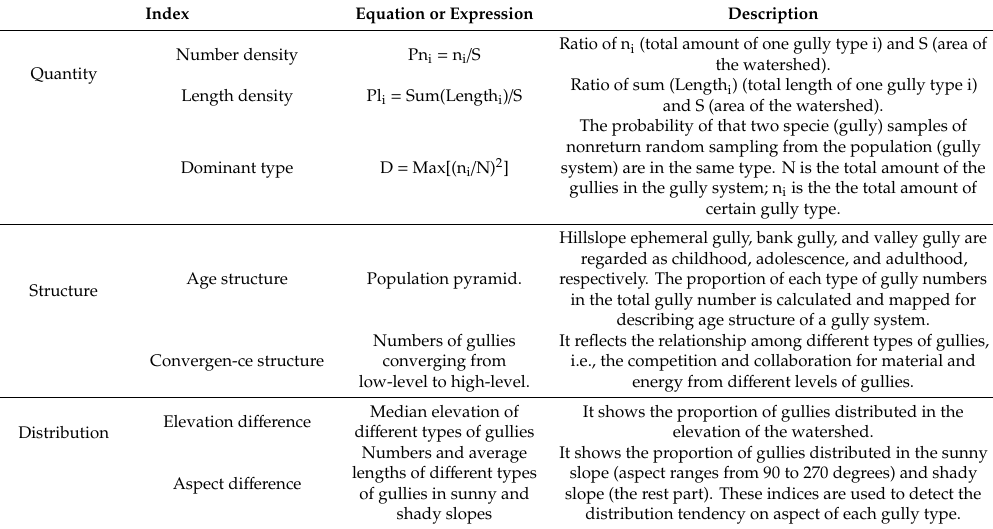
Table 3. Descriptive Indices for Population Characteristics of the Loess Gully